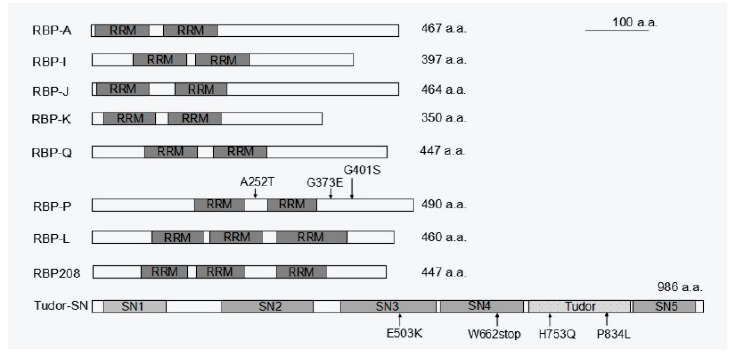
Figure 5. Schematic structure of the available RBPs responsible for prolamine and/or glutelin mRNA localization. While RBP-A, I, J, K, Q, and P contain two RRM motifs, there are three RRMs in RBP-L and RBP208. Tudor-SN consists of four SN-like domains (SN1 to 4) followed by a Tudor domain and a fifth abbreviated SN-like domain (SN5). The mutations sites in RBP-P and Tudor-SN that cause mislocalization of prolamine and glutelin mRNAs are indicated by arrows followed by labeling amino acid substitutions. a.a., amino acids.